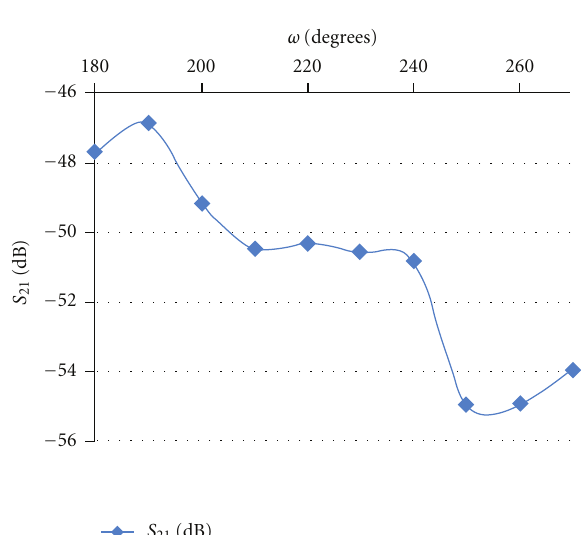
Figure 19: S 21 as a function of angle ω for configuration